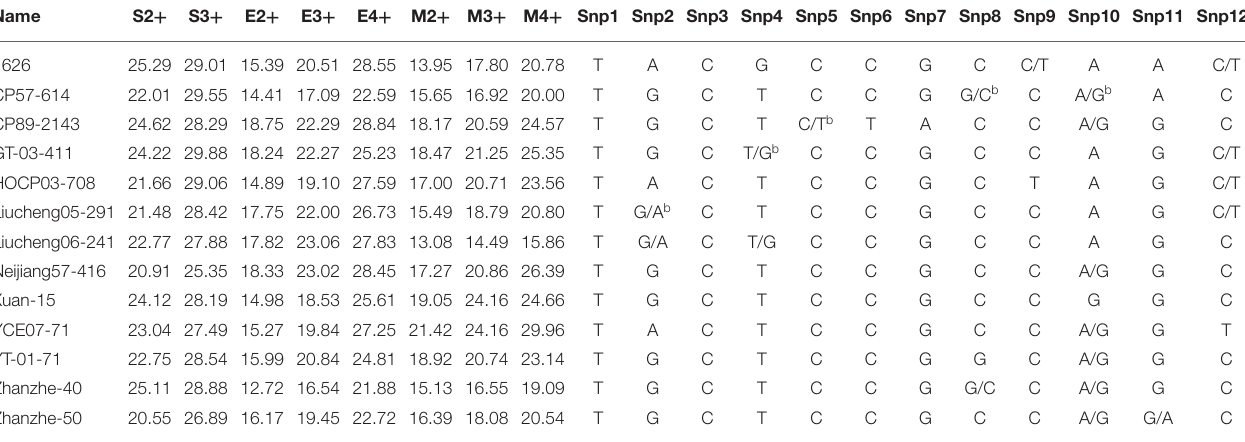
TABLE 3 | The elite core parents and their derivatives with narrow leaf angle and the nearest